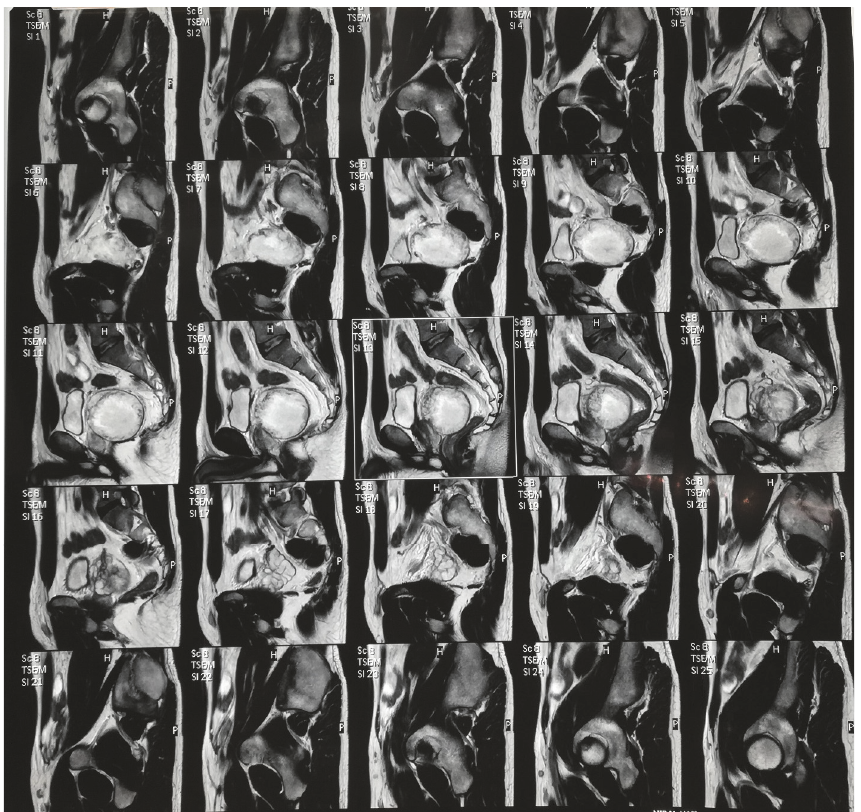
Figure 1: Pelvic MRI showing a large mass confined to the pelvis measuring 7.2 cm in the largest diameter with predominance of cystic component without evidence of fatty content, calcification, fluid-fluid level, or suspicious enhancing nodular soft tissue thickening.